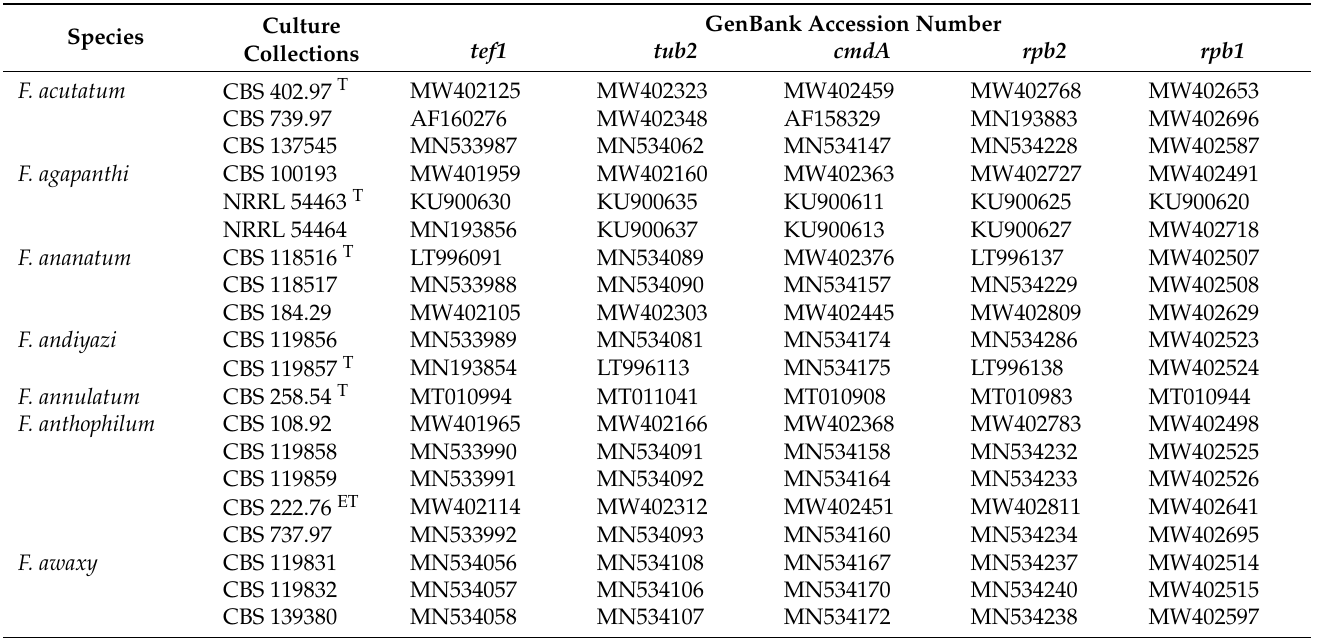
Table 1. Strains of the Fusarium fujikuroi species complex used in this study with GenBank accession